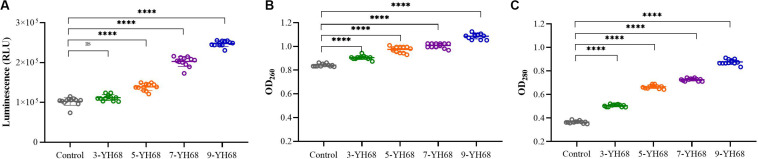
Effects of YH68-CFCS at different doses on C. difficile cells. (A) Luminescence values represent the extracellular ATP level, (B) OD260 values represent the extracellular nucleic acid substances level, (C) OD280 values represent the extracellular protein substances level. (Sterile water is used as a control, ns, not significant, and ****P < 0.0001; Dunnett’s multiple comparisons test).